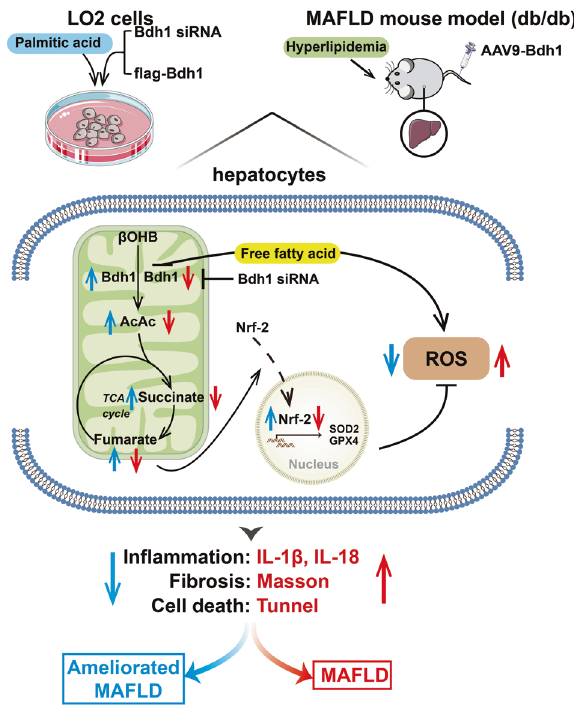
Fig. 8 Schematic diagram depicting the mechanism by which Bdh1-mediated β OHB metabolism ameliorates MAFLD. Hyperlipi- demiain db/db mice or palmitic acid treatment in LO2 cells leads to reduction of Bdh1 expression, which subsequently downregulates the fumarate level by metabolic fl ux composed of β OHB-AcAc- Succinate-Fumarate. The reduced fumarate level decreases nuclear translocalization of Nrf2, inducing overproduction of ROS, which fi nally activates the in fl ammation, fi brosis and apoptosis in MAFLD. In addition, overexpression of Bdh1 in LO2 cells or db/db mice could reverse the pathological injury by increasing fumarate/Nrf2/ ROS